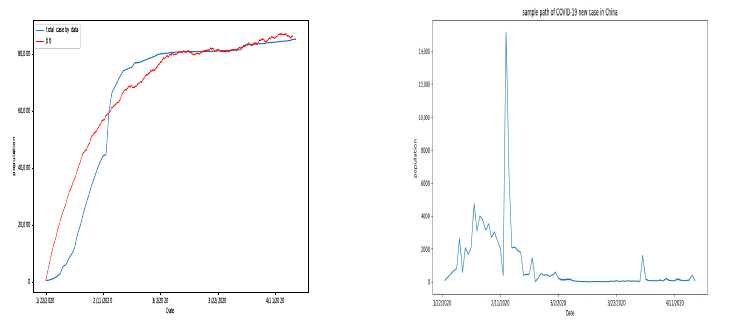
Figure 3. Prediction and actual accumulated cases in China ( left ) and new confirmed cases in China ( right ).